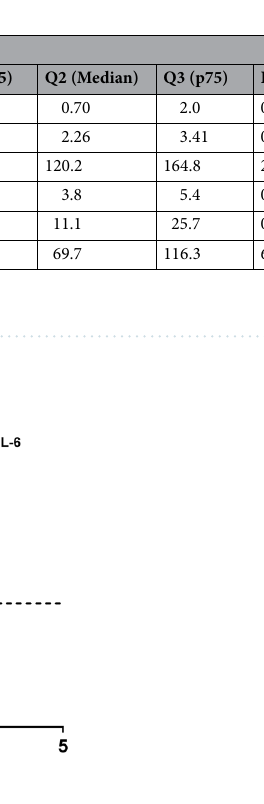
Figure 1. Volcano plot displaying the fold change (log 2 ) in tested cytokine levels in sera of female patients with RA as opposed to healthy